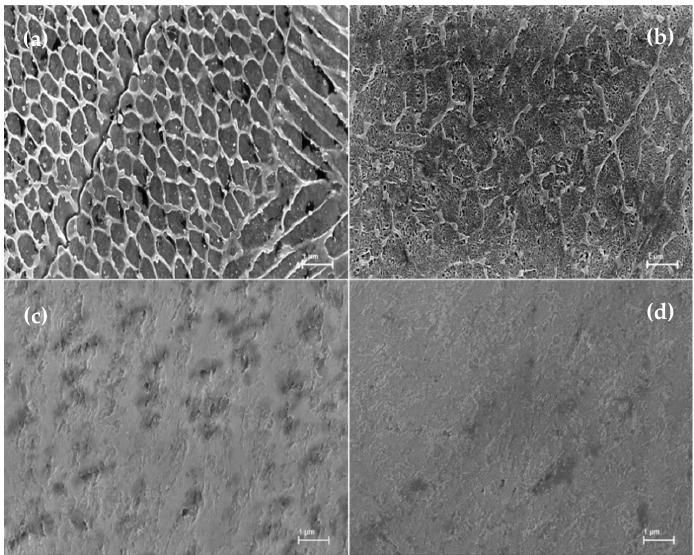
Figure 4. Microstructure (SEM) of V ‐ printed samples with different heat ‐ treatments: ( a ) 0VAP; ( b ) 0V490; ( c ) 0V600; and ( d ) 0V900. The scale is 1.0 μ m.